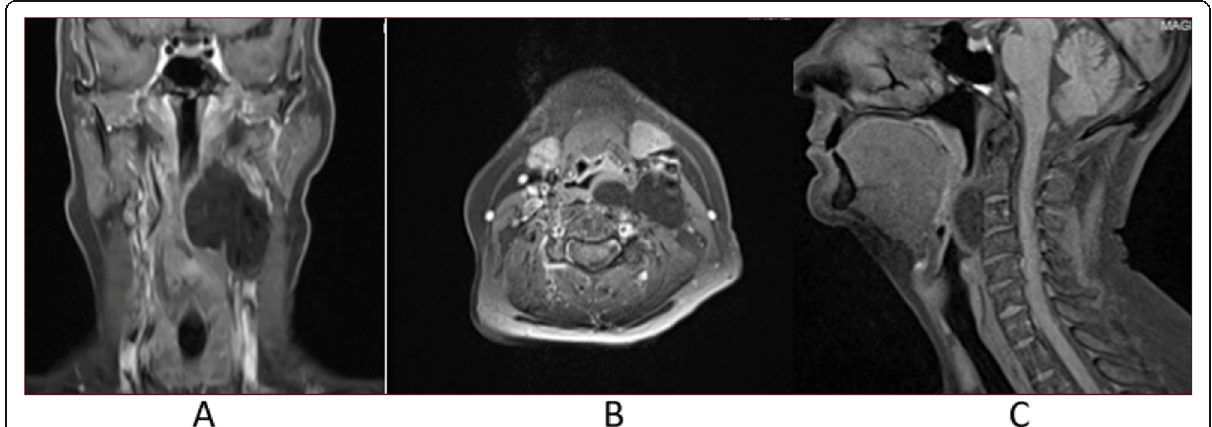
Fig. 4 MRI T1-weighted with fat suppression coronal ( a ), axial ( b ), and sagittal ( c ) images depicting a homogeneous loss of signal within the lesion